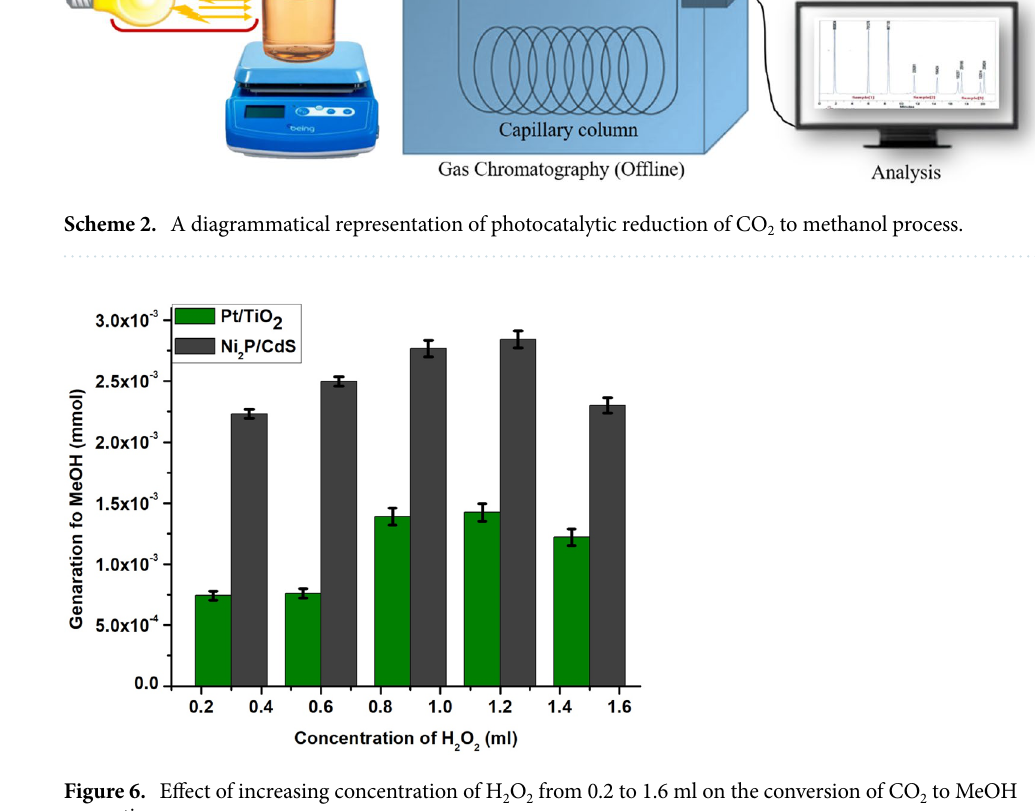
Figure 6. Effect of increasing concentration of H 2 O 2 from 0.2 to 1.6 ml on the conversion of CO 2 to MeOH generation.